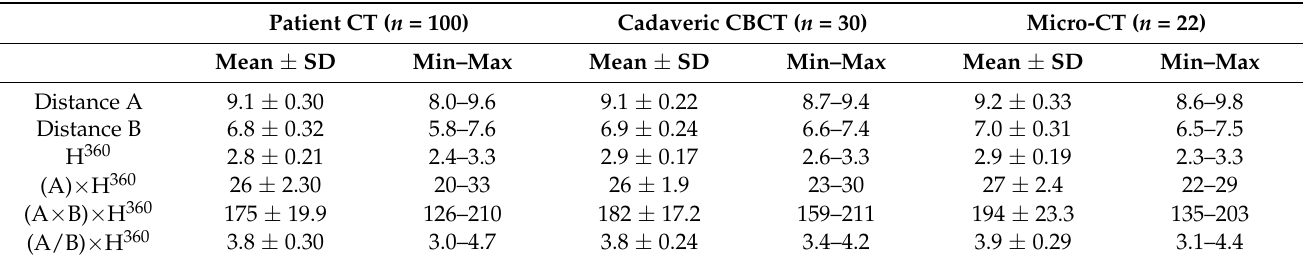
Table 1. Cochlear dimensions of 100 pre-implantation cochleae. The three indices (A)×H 360 , (A×B) ×H 360 , and (A/B)×H 360 have a Gaussian distribution.